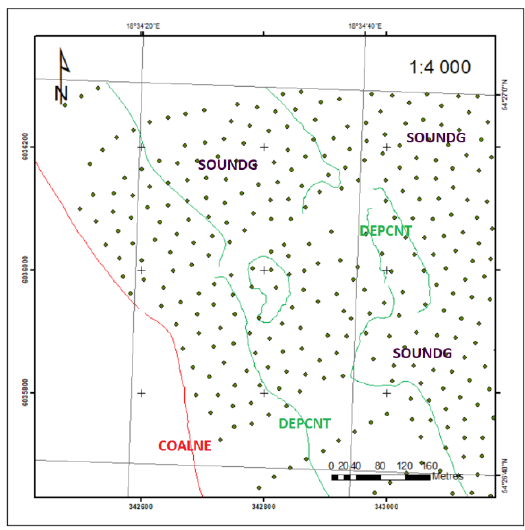
Figure 6. Geospatial data extracted from ENC in 2018.